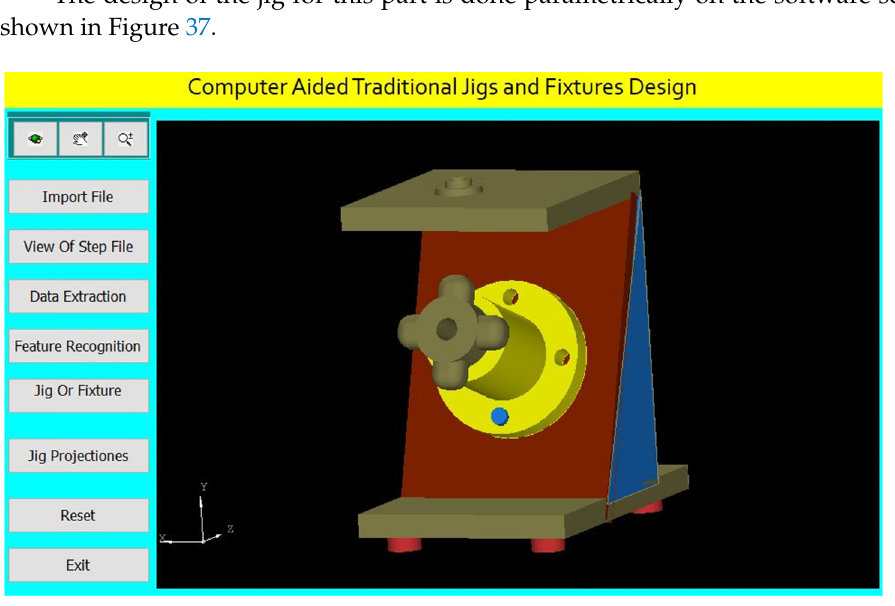
Figure 37. Computer-aided design of a jig for the cylindrical part.